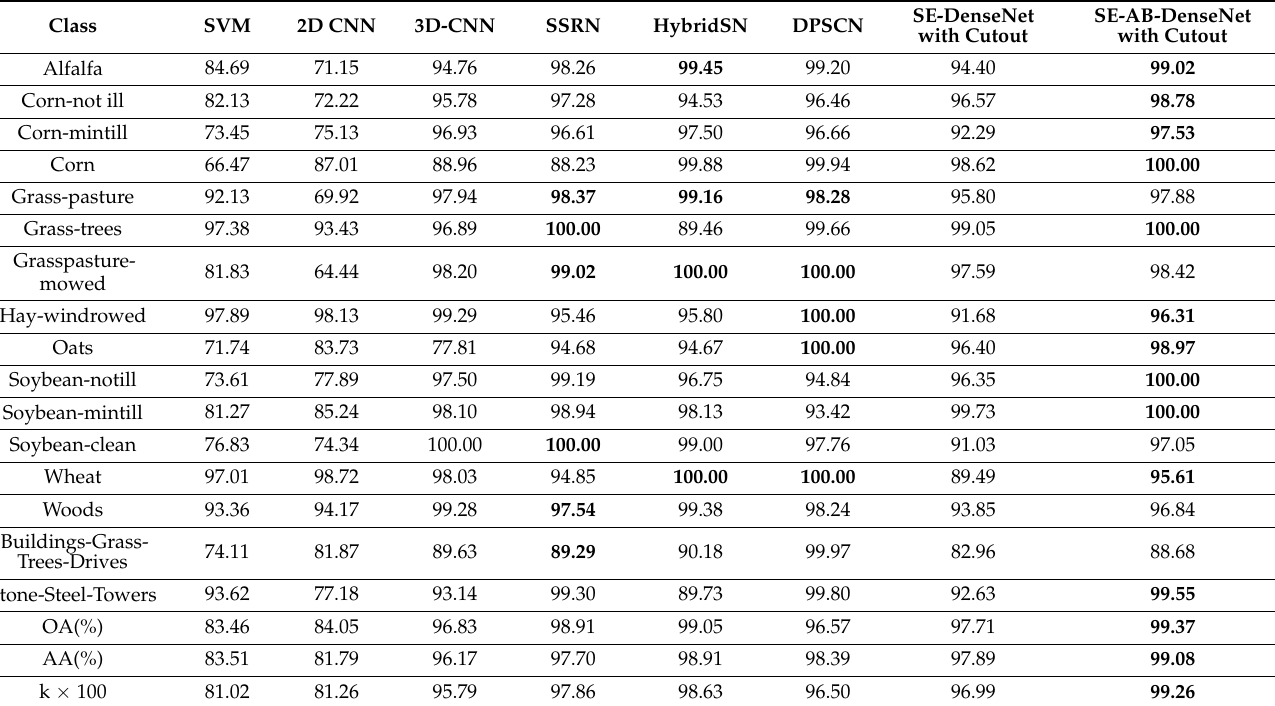
Table 4. Class-wise overall accuracy (OA%), average accuracy (AA%), and k kappa are represented for the Indian Pines dataset. This table displays the best accuracy of distinct classes obtained in each classifier (bold highlighted